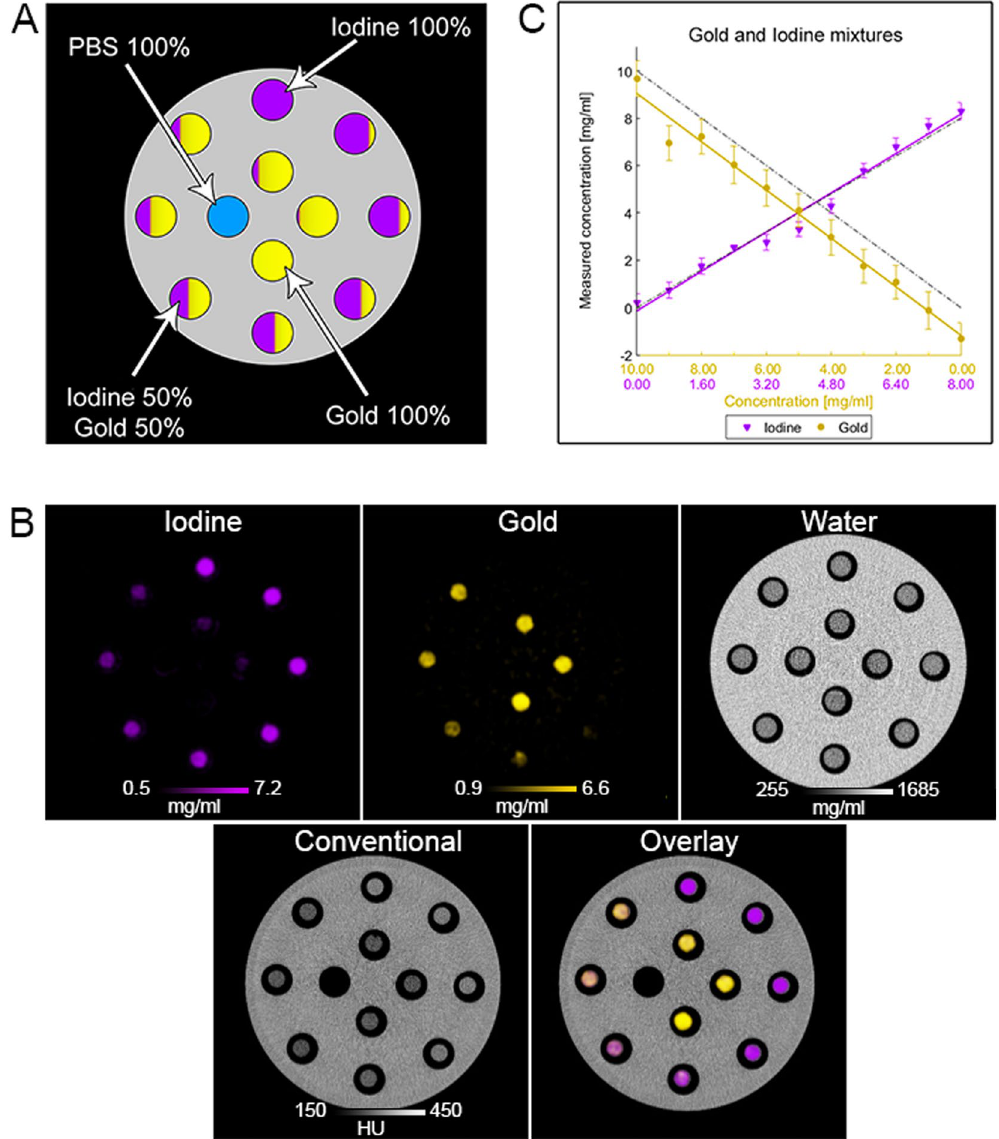
Figure 4. ( A ) Schematic of the phantom with mixed solutions. ( B ) Conventional, gold, iodine, water and overlay images are depicted. ( C ) Comparison of the expected and the measured